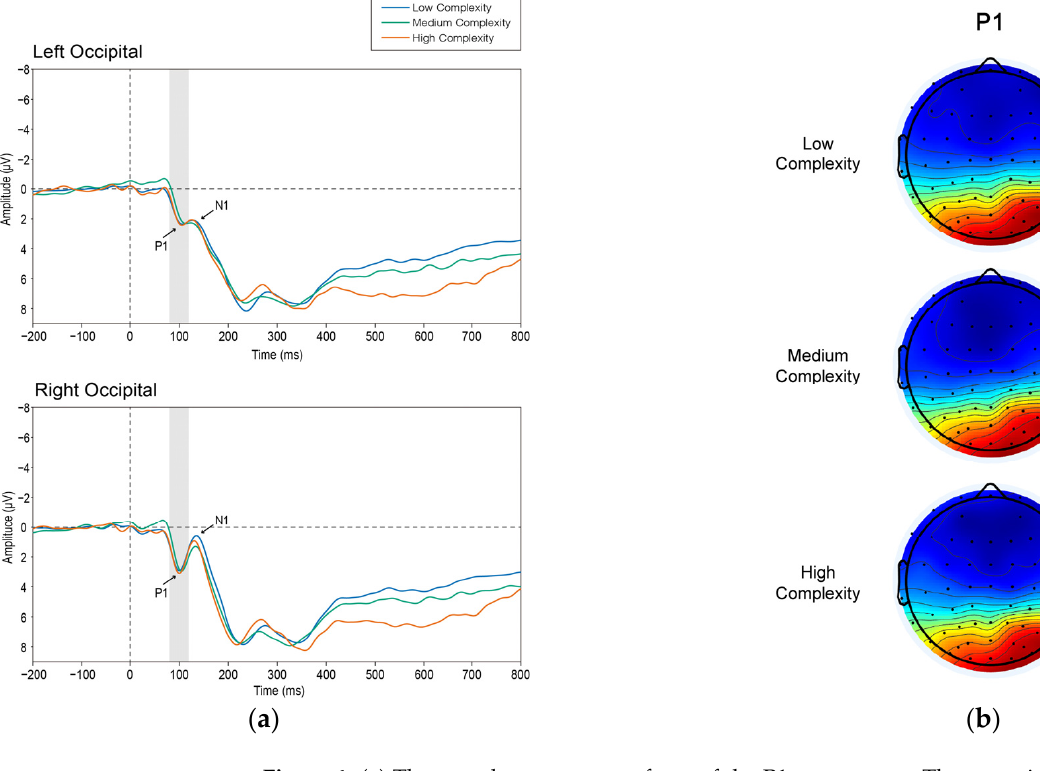
Figure 4. ( a ) The grand average waveform of the P1 component. The wave in blue represents the low-complexity condition, the wave in green represents the medium-complexity condition, and the wave in red represents the high-complexity condition. The gray bars indicate the time window of the P1. ( b ) The mean voltage 2D topography map of the P1 component. The color red means higher positive amplitudes, while the color blue means more negative amplitudes.